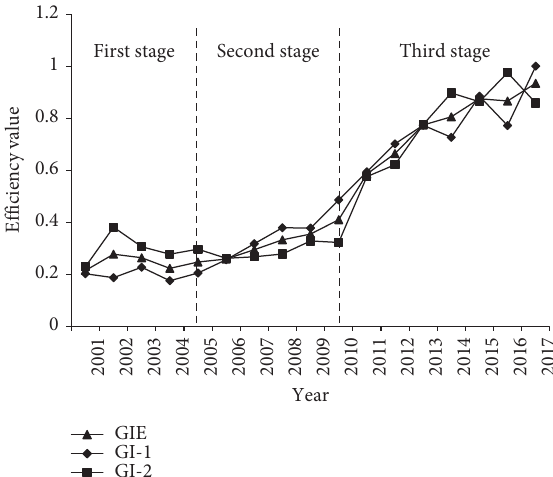
Figure 2: Trend of green innovation efficiency and its components during